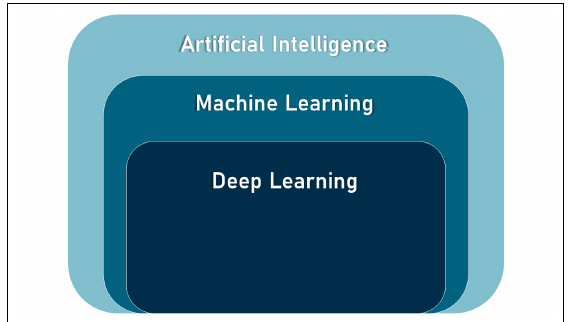
Figure 6. Artificial intelligence, machine learning, and deep learning